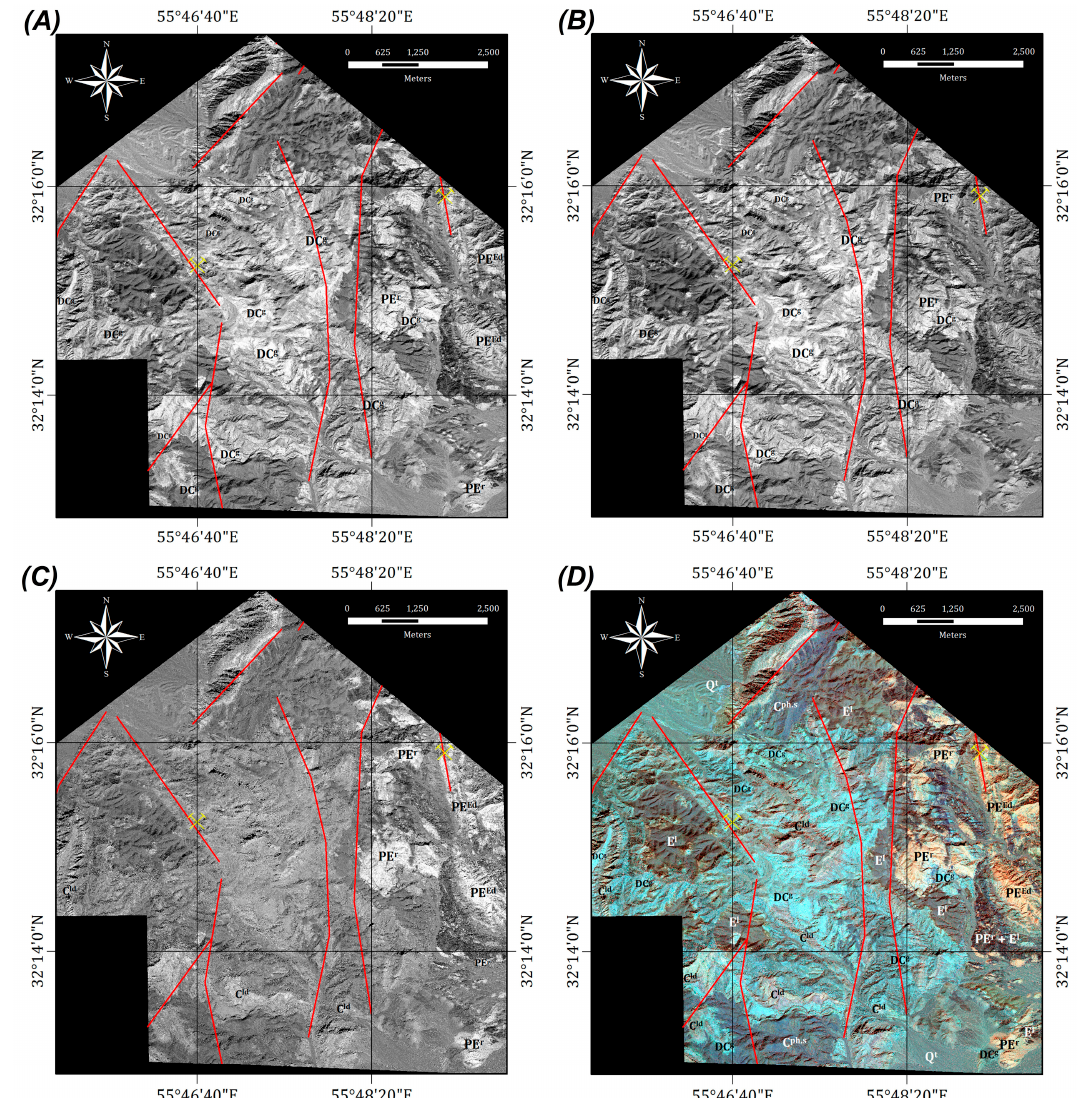
Figure 10. WV-3 scene covering the selected subset of the study area containing Zn–Pb mineralization. ( A ) The band ratio image-map of 5/3 for mapping Fe 3+ oxides; ( B ) the band ratio image-map of 5/2 for identifying all iron oxides (iron-stained alteration); ( C ) the band ratio image-map of 7/4 for detecting dolomite/Fe 2+ ; ( D ) RGB false color composite image-map of 7/4, 5/3 and 5/2 for discriminating lithological units.